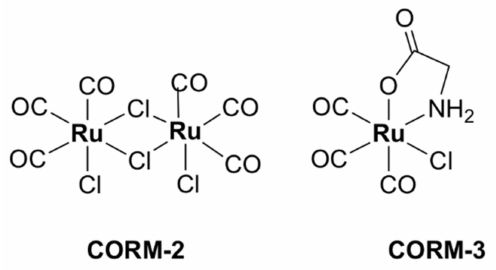
Figure 18. Chemical structures of CORM-2 and